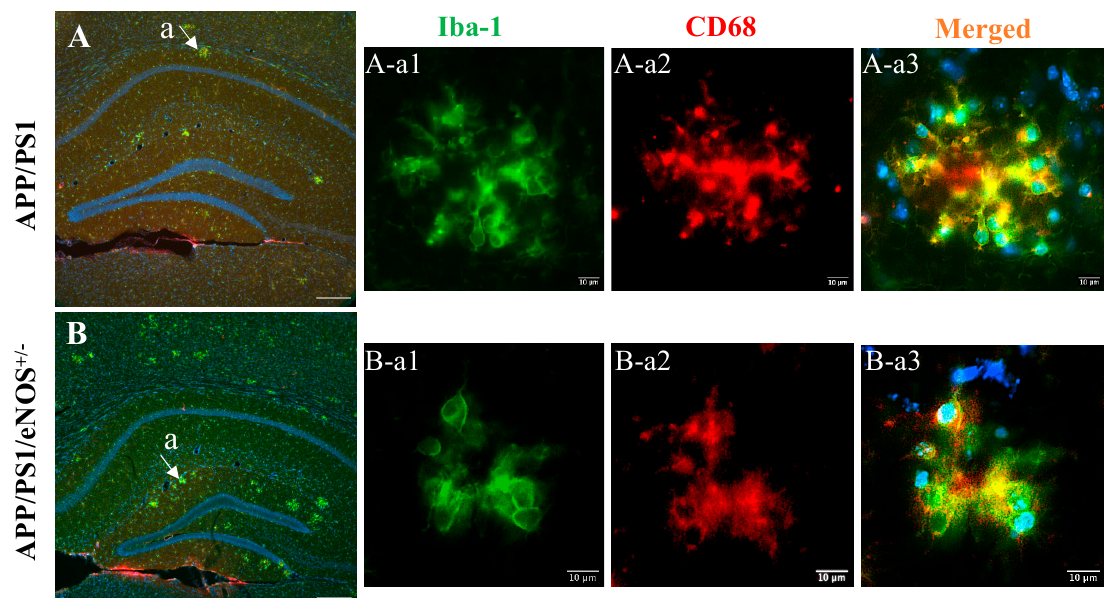
Figure 5. Representative immunofluorescent staining of Hoechst (blue; A , E , I , M ), Hoechst/Iba-1 (green; B , F , J , N ), Hoechst/6E10 (red; C , G , K , O ) and merged Hoechst/Iba-1/6E10 ( D , H , L , P ) in the hip- pocampus of 8-months old male WT, eNOS +/ − , APP/PS1 and APP/PS1/eNOS +/ − mice at 10X magnifi- cation (scale bar 200 μ m). High magnification (40X) images of merged Hoechst/Iba-1/6E10 staining in the area labeled a in WT ( D-a ), eNOS +/ − ( H-a ), APP/PS1 ( L-a ) and APP/PS1/eNOS +/ − mice ( P-a ) (scale bar 30 μ m).